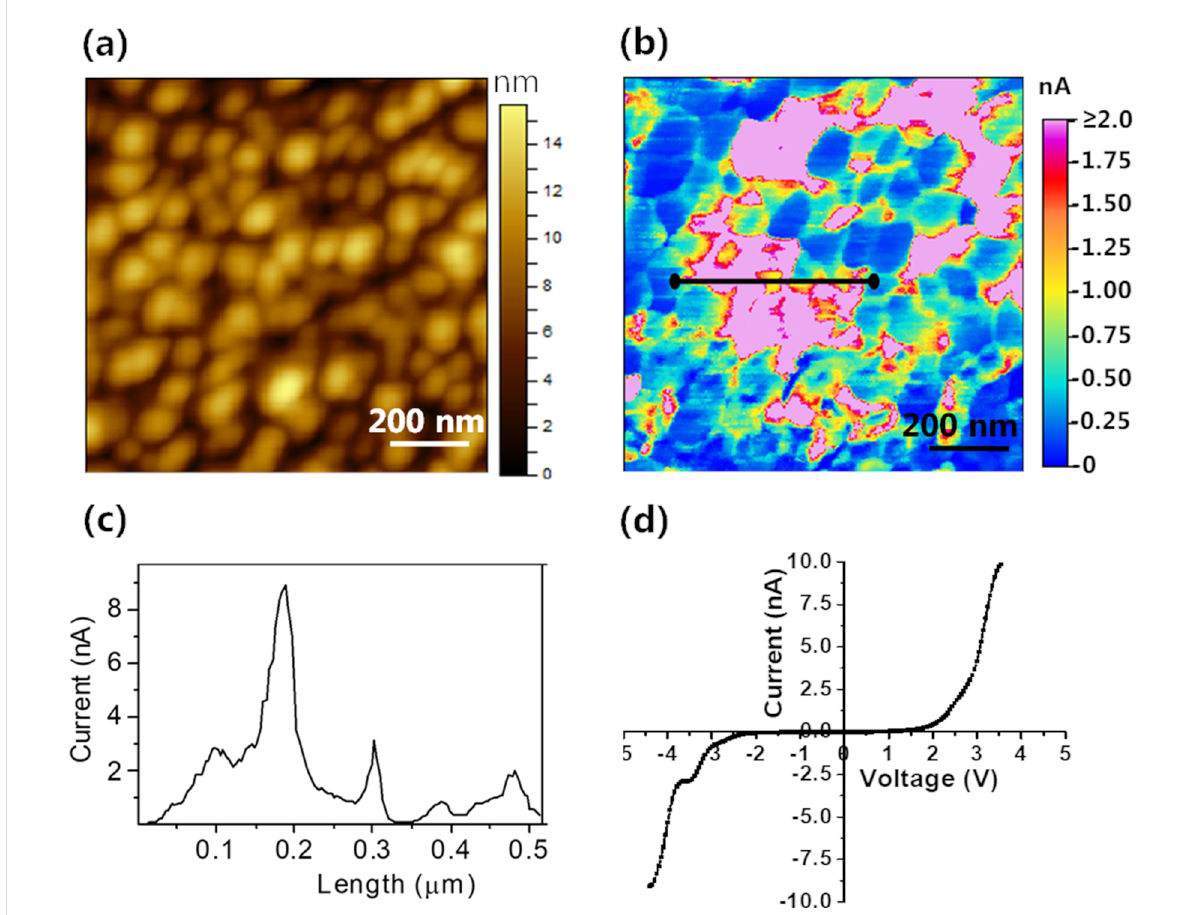
Figure 6: (a) AFM topography,1 µm × 1 µm scan area. (b) Corresponding current map of 10 nm PbPc thin film on SLG/SiO 2 /Si substrate obtained at 2 V sample bias. (c) Profile section of (b) along the marked line showing the current variation across the film. (d) I – V curve acquired from a conduct- ing